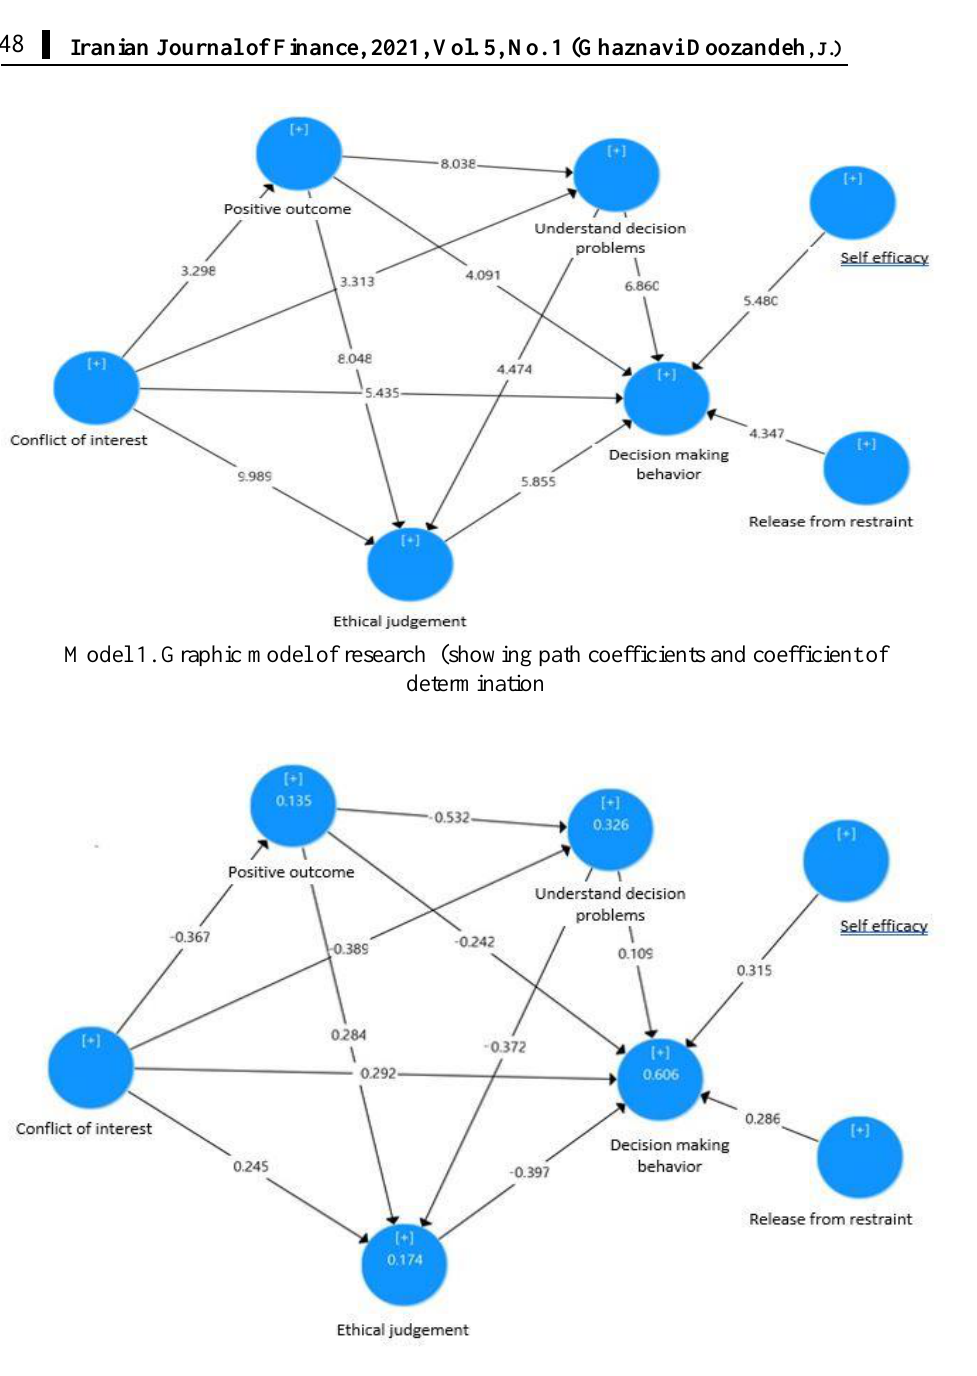
Model 2. Graphic model of the research (shows the significance of the